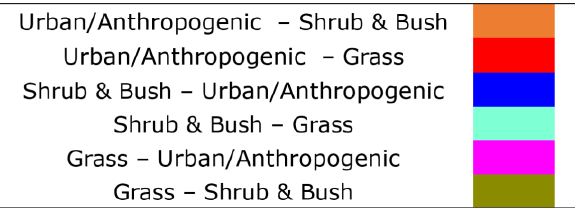
Figure 11. Legend representing the class transitions in the change map of Figure 10f. Table 3. Accuracy scores on the test samples for the two classification maps obtained with